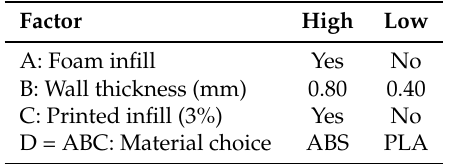
Table 2. Selected experimental factors and levels.